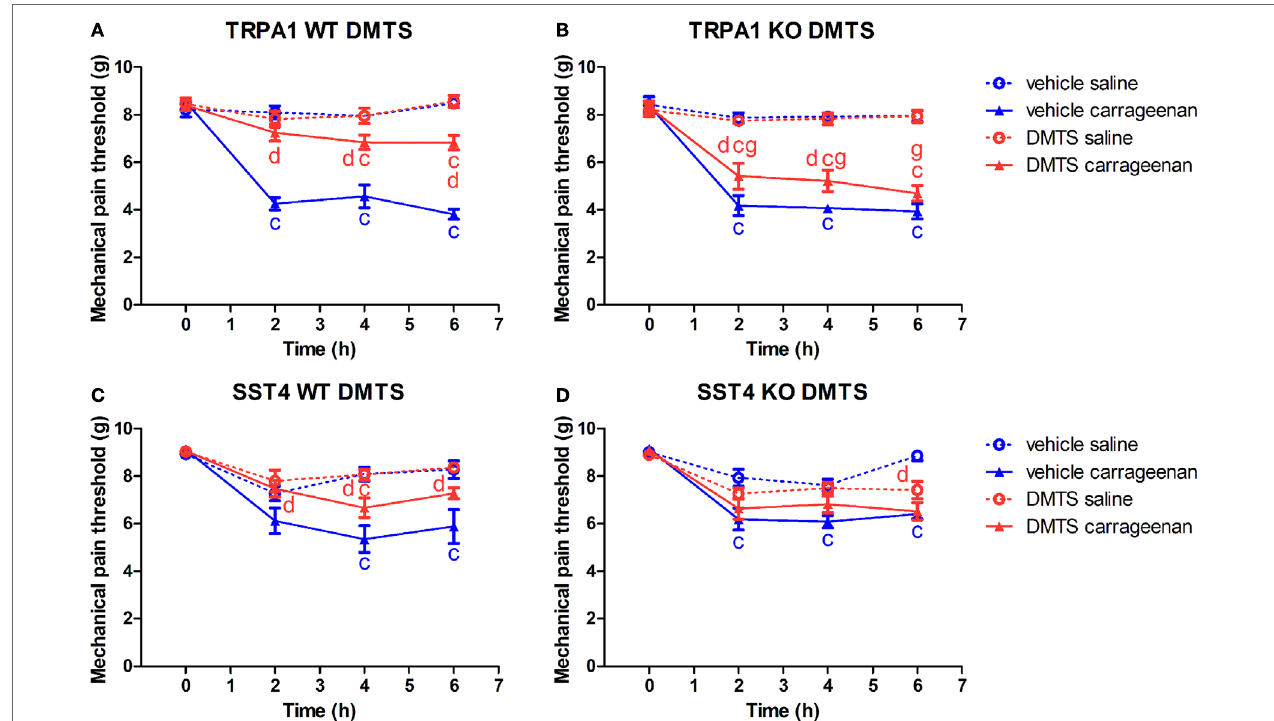
FigUre 2 | Antinociceptive effect of dimethyl trisulfide (DMTS, 250 µmol/kg) in carrageenan-evoked paw inflammation is independent of the transient receptor potential ankyrin 1 (TRPA1) ion channel, but is mediated by somatostatin (SOM) sst4 receptors. Effect of DMTS or vehicle treatment on mechanical pain threshold of either saline or carrageenan-treated (3% in 20 µL saline) hind paws of (a) TRPA1 WT, (B) TRPA1 KO, (c) sst4 receptor WT, and (D) sst4 receptor KO mice. Data are shown as mean ± SEM. n = 6–8. c p < 0.05 vs. saline-injected paws. d p < 0.05 vs. vehicle of DMTS. g p < 0.05 vs. TRPA1 WT animals. Two-way repeated-measure ANOVA followed by Bonferroni’s multiple comparison